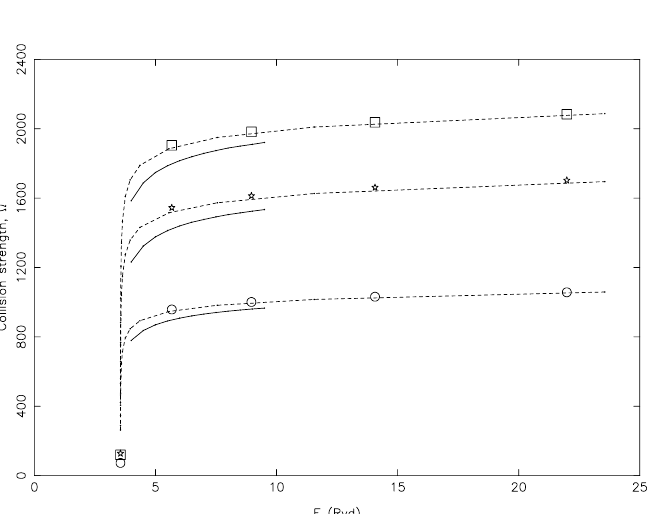
–3d 2 D 3/2 ), 6–8 (3s 2 S 1/2 –3p 2 P o ) 1/2 3/2